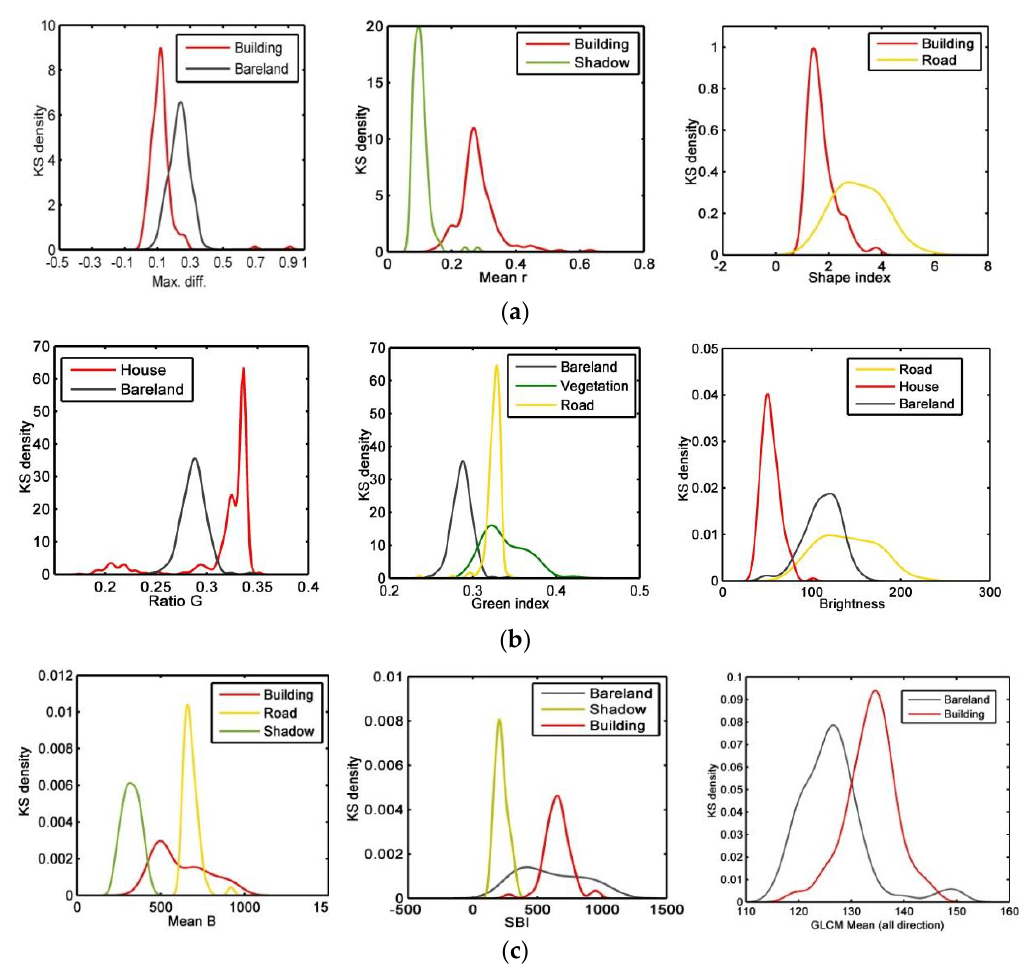
Figure 8. Probability distribution density of different object features based on extraction from high-resolution images (( a ) BJ-2 imagery, ( b ) UAV imagery, and ( c ) GF-2 imagery).